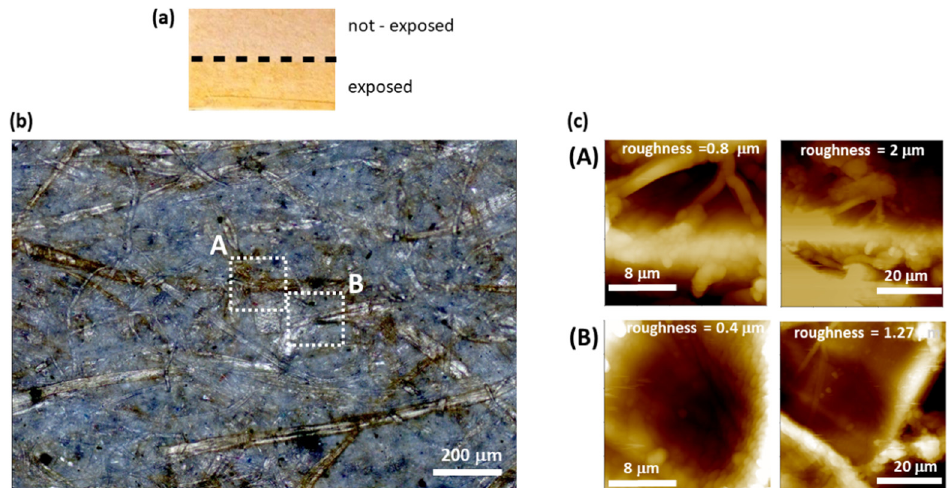
Figure 1. ( a ) Sketch of the portion of paper sample masked to the laboratory natural light. ( b ) Optical microscope image of the seven months exposed part of paper sample and ( c ) AFM images taken in the region ( A ) browned fiber, and ( B ) white fiber.